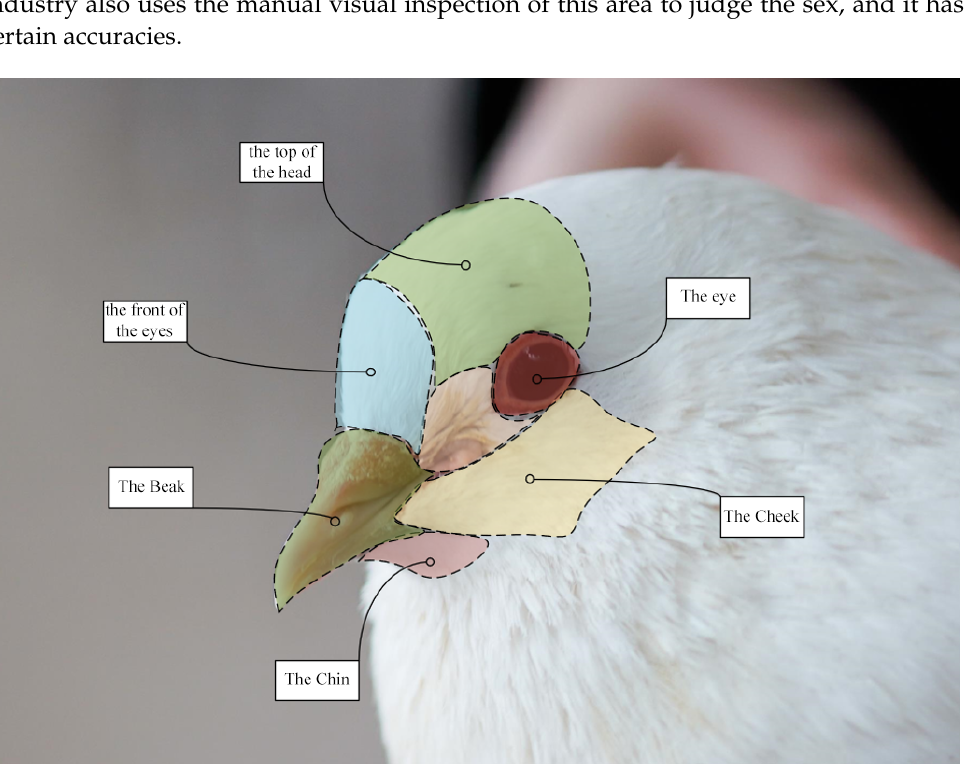
Figure 2. Names of several areas in the pigeon